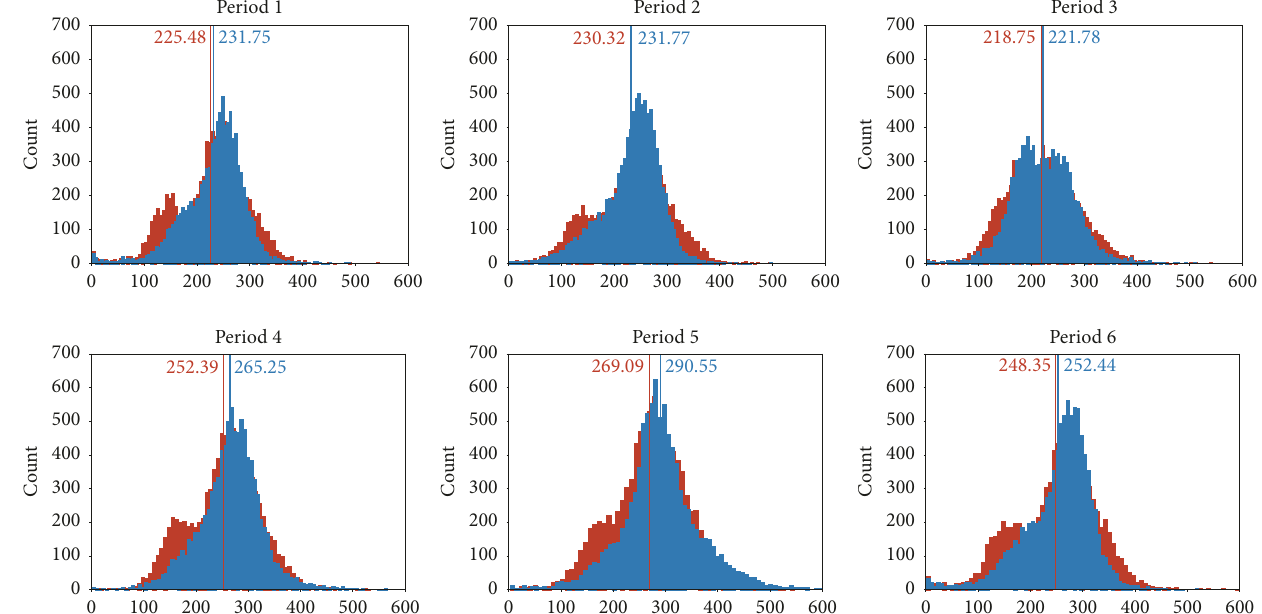
Figure 5: Histograms of the unweighted area of the operation zones (in blue) and weighted area of the operation zones (in red) of all of the selected taxis in each period. The blue vertical line represents the mean value of the unweighted area of the operation zones, and the red vertical line represents the mean value of the weighted area of the operation